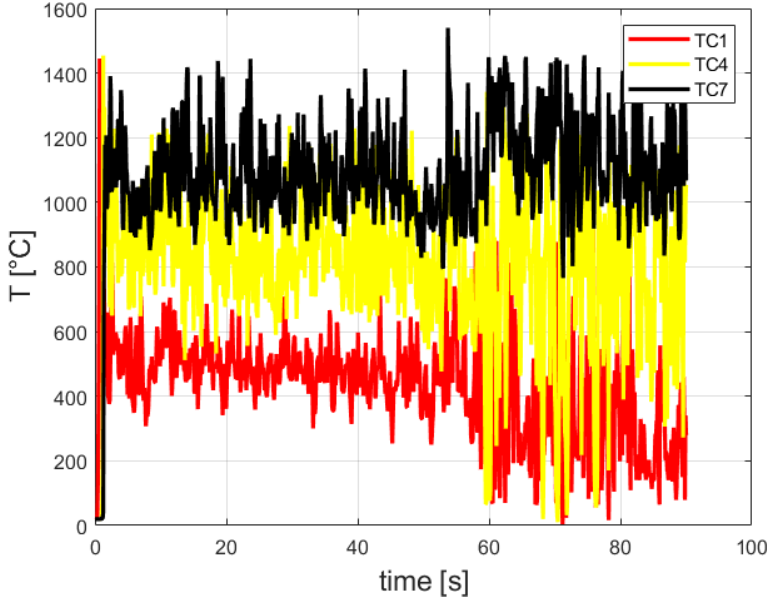
Figure 7. Temperature readings of the three thermocouples TC1, TC4 and TC7.